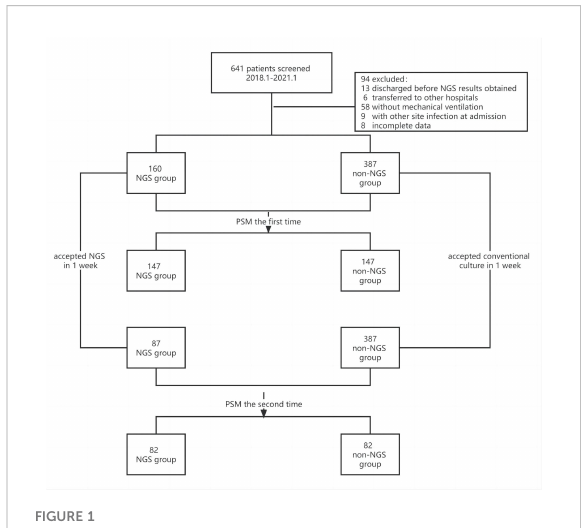
FIGURE 1 Flow chart of patients